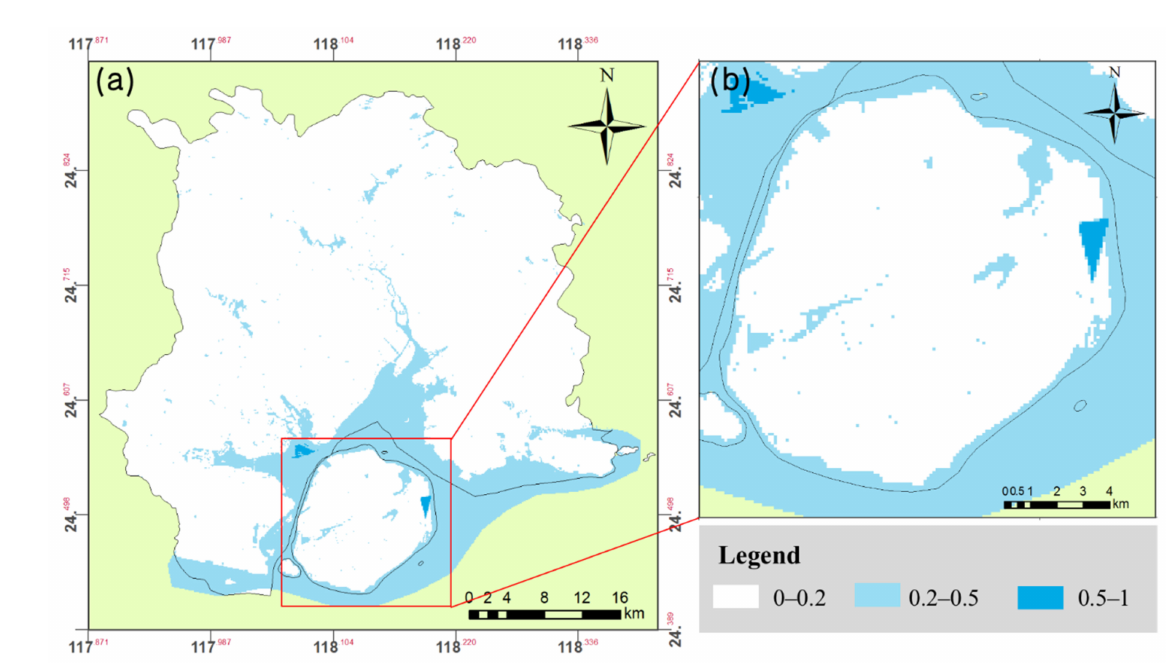
Figure 12. ( a ) Water grids; and ( b ) zoomed-in area of the red